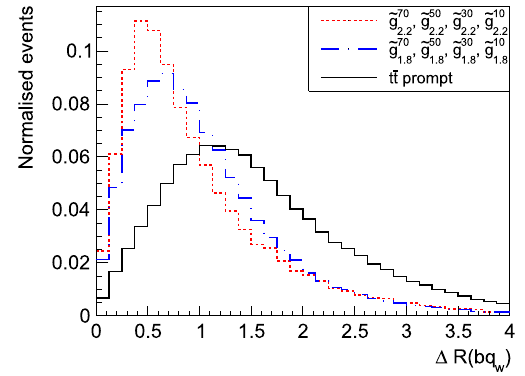
Fig. 80 (cid:6) R distributions in the gluino ˜ g